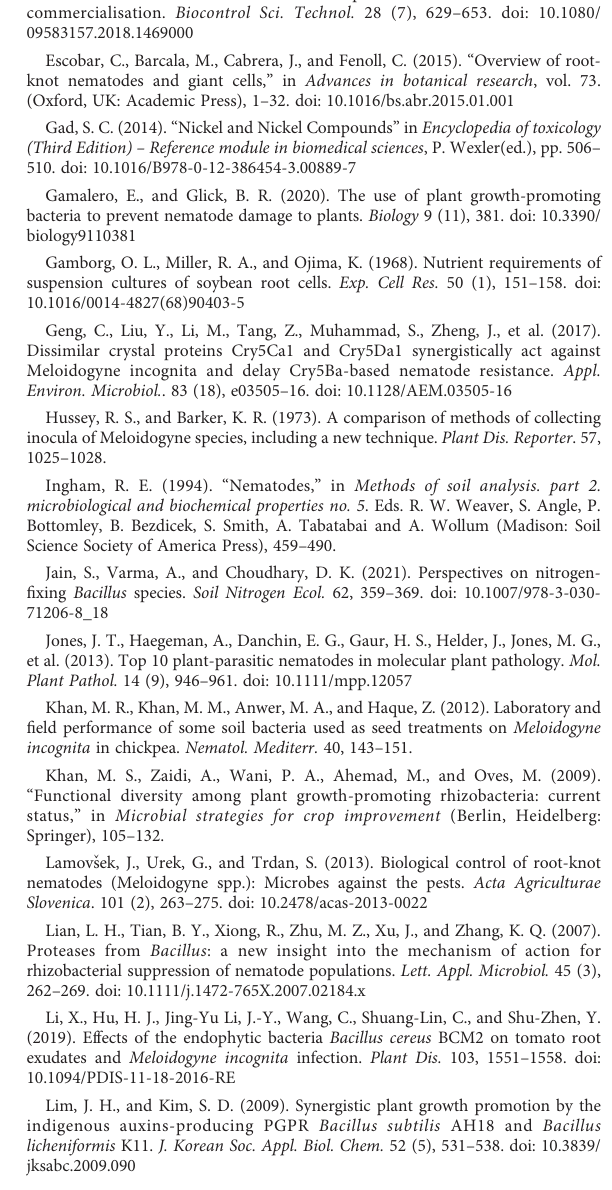
correspond to the experiments in . Bars are mean ± stand error (n=24). Data were analyzed using t-test and no signi fi cance differences were encountered at p<0.05. SUPPLEMENTARY FIGURE 3 Representative diagram of the attraction assay. Roots of tomato seedlings were immersed in a suspension of 1,0 x10^6 CFU/ml of the dual-strain combination of B. paralicheniformis FMCH001 and B. subtilis FMCH002 and placed in the plate with pluronic gel. After 24 hours, 600 J2 were distributed through fi ve spots at the bottom of the plate. The number of